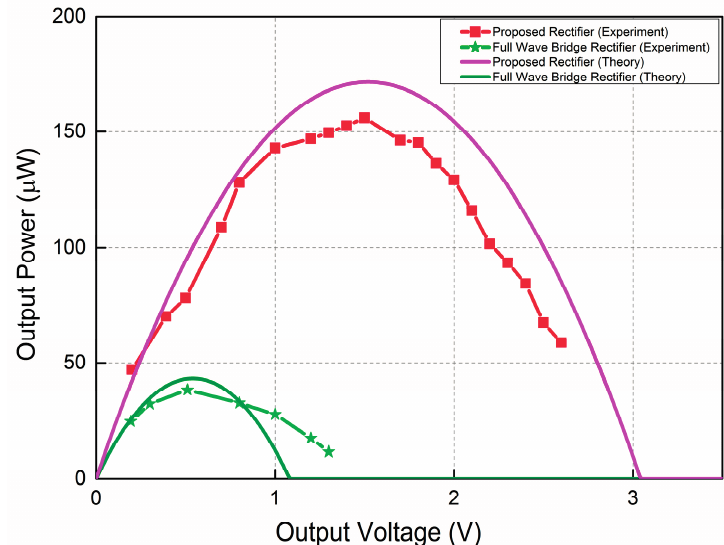
Figure 9. Measured output power.